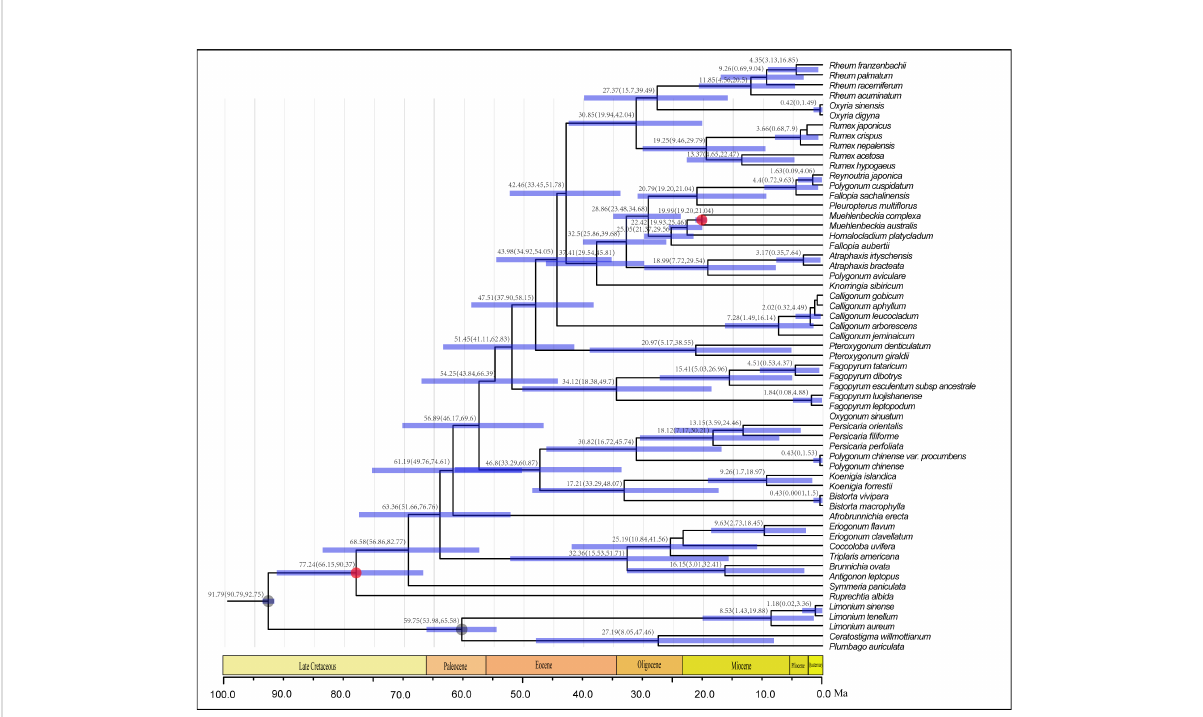
FIGURE 4 BEAST-derived chronogram of Polygonaceae based on three chloroplast fragments with two fossil calibration (red circles) and two second calibration point (gray circles), fossils ’ information were provided in Supplementary Methods S1. Numbers above the tree branches represented mean divergent ages and 95% con fi dence interval of each node. Blue bars indicate the 95% highest posterior density (HPD) con fi dence intervals for node ages